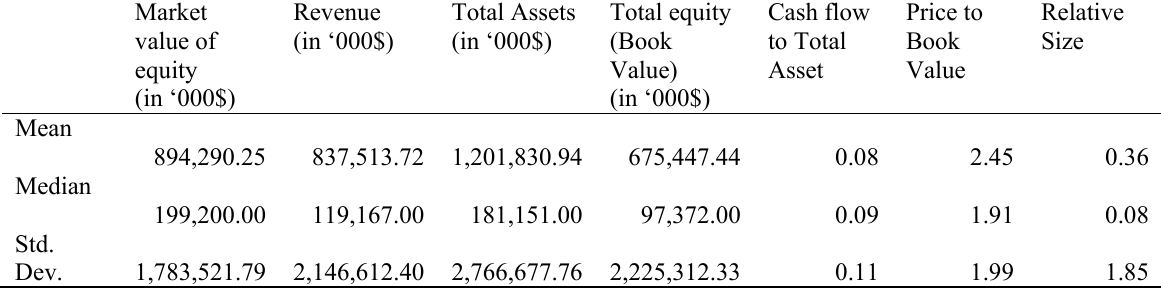
Table 3. Descriptive Statistics of Firm-Specific Variables for Acquiring Firms The sample consists of 925 annual observations for acquiring firms between 1993 and 2002. For acquiring firms, only one event is considered in case of multiple acquisitions by the firm in any year. “Market vale of equity” is the total market value of the acquiring firm’s equity in the preceding year of M&A event “Market value of equity” is calculated as the year end share price multiplied by number of outstanding shares. “Revenue” is the annual sales revenue of the acquiring firm. “Total assets” and “Total equity” are obtained from acquiring firm’s balance sheet. “Cash flow to total asset” is the ratio of operating cash flow to total asset of acquiring firm. “Price to book value” is the ratio of market price of share to the book value per share. “Relative size” is the ratio of transaction value and market value of the acquiring firm’s equity. Panel A. Full sample (N =